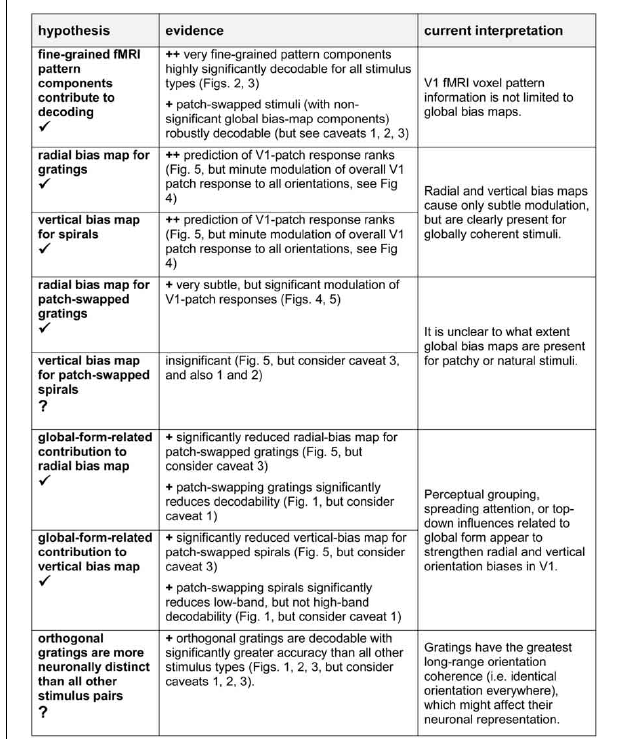
FIGURE 9 | Hypotheses, evidence from this study, and our current interpretation. In the hypothesis column, a checkmark indicates the presence of significant evidence in favor of the hypothesis; a question mark indicates that the evidence is weak or absent. In the evidence column, ++ indicates strong evidence, + indicates evidence to be considered in the light of potential caveats. Caveats: (1) Imprecise fixation may have blurred the V1-patch checkerboard entailing greater reduction of decoding contrast for patch-swapped than for globally coherent stimuli. (2) Imprecise fixation may also have added noise to the local orientation signal for all stimuli, except gratings. However, our task required continual fixation to discern tiny foveal cues. Successful performance suggests that lapses of fixation were minimal. (3) Imprecision in V1 patch definitions might have led to reduced patch contrast for patch-swapped stimuli, where the preference predicted by the global map inverts for adjacent patches. However, a control analysis (see Results, Discussion) did not support this